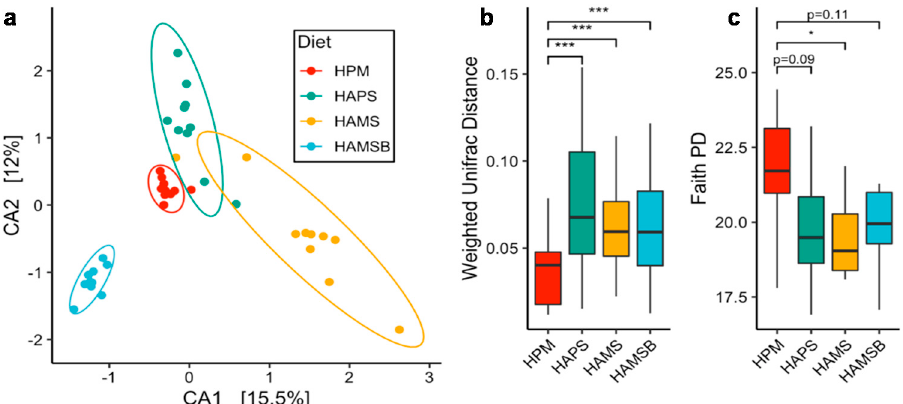
Figure 1. Resistant starch changes the composition of the rat cecal microbiota. ( a ) Canonical correspondence analysis of the weighted UniFrac distance metric. Each point represents an individual rat cecal community. ( b ) Boxplots of weighted UniFrac distances and ( c ) Faith’s Phylogenetic Diversity (PD). HPM—high protein meat, HAPS—HPM + high amylose potato starch, HAMS—HPM + high amylose maize starch, HAMSB—HPM + butyrylated high amylose maize starch. ANOVA followed by pairwise Tukey HSD was performed for quantifying the statistical differences in alpha and beta diversity ( n = 10 rats per treatment group). * p < 0.5, *** p < 0.001.